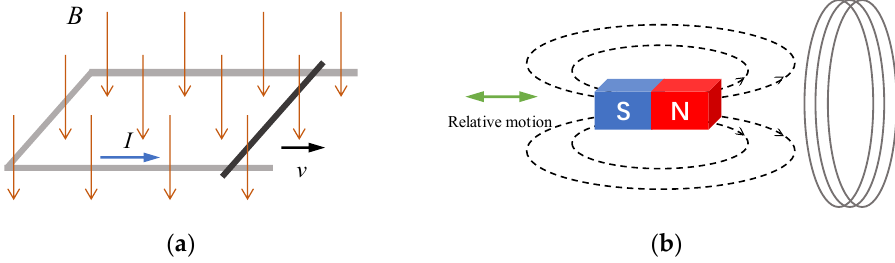
Figure 2. ( a ) Schematic and ( b ) configuration of electromagnetic energy harvesting.